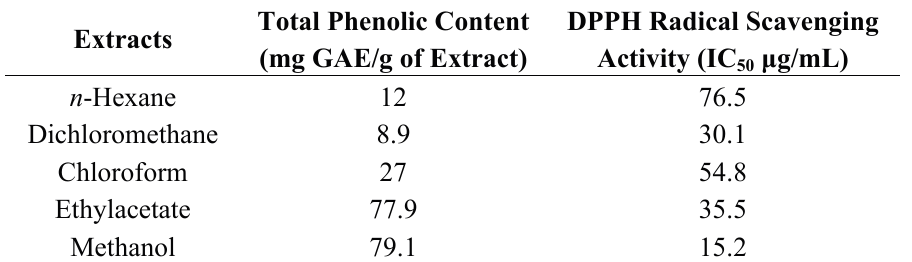
Table 17. Total phenolic content and antiradical activity of blackberry extracts [104].